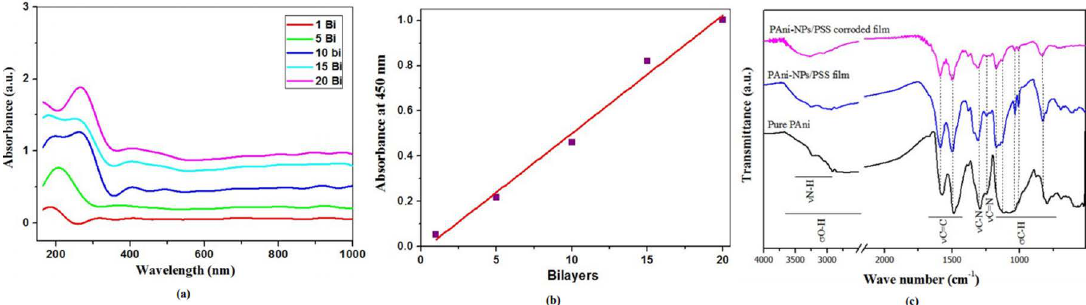
Figure 3. (a) UV-Vis spectra of PAni-NPs/PSS LbL films at different number of bilayers and (b) linear growth of bilayers for PAni-NPs/ PSS LbL films (Absorption of PAni at 450 nm), (c) FTIR spectra of Pure PAni, PAni-NPs/PSS and PAni-NPs/PSS corroded film. The lines and dots are only guide for the